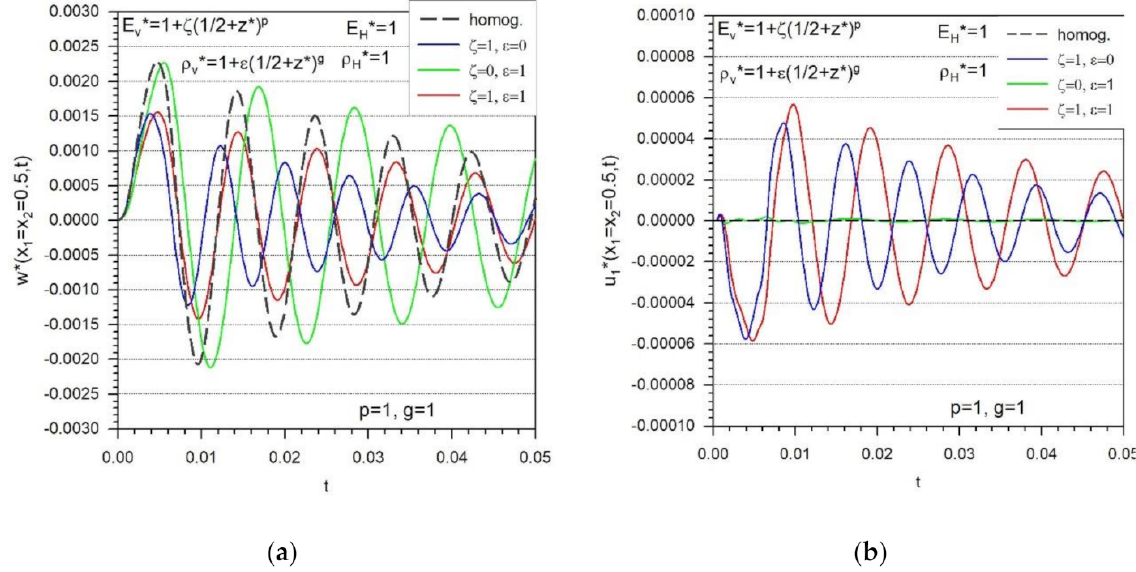
Figure 8. Comparison of influences of the various combinations of the level of gradation of the mass density ( ε ) and/or the elastic modulus ( ζ ) on the time variation of: ( a ) the dimensionless central deflection, ( b ) the dimensionless in-plane